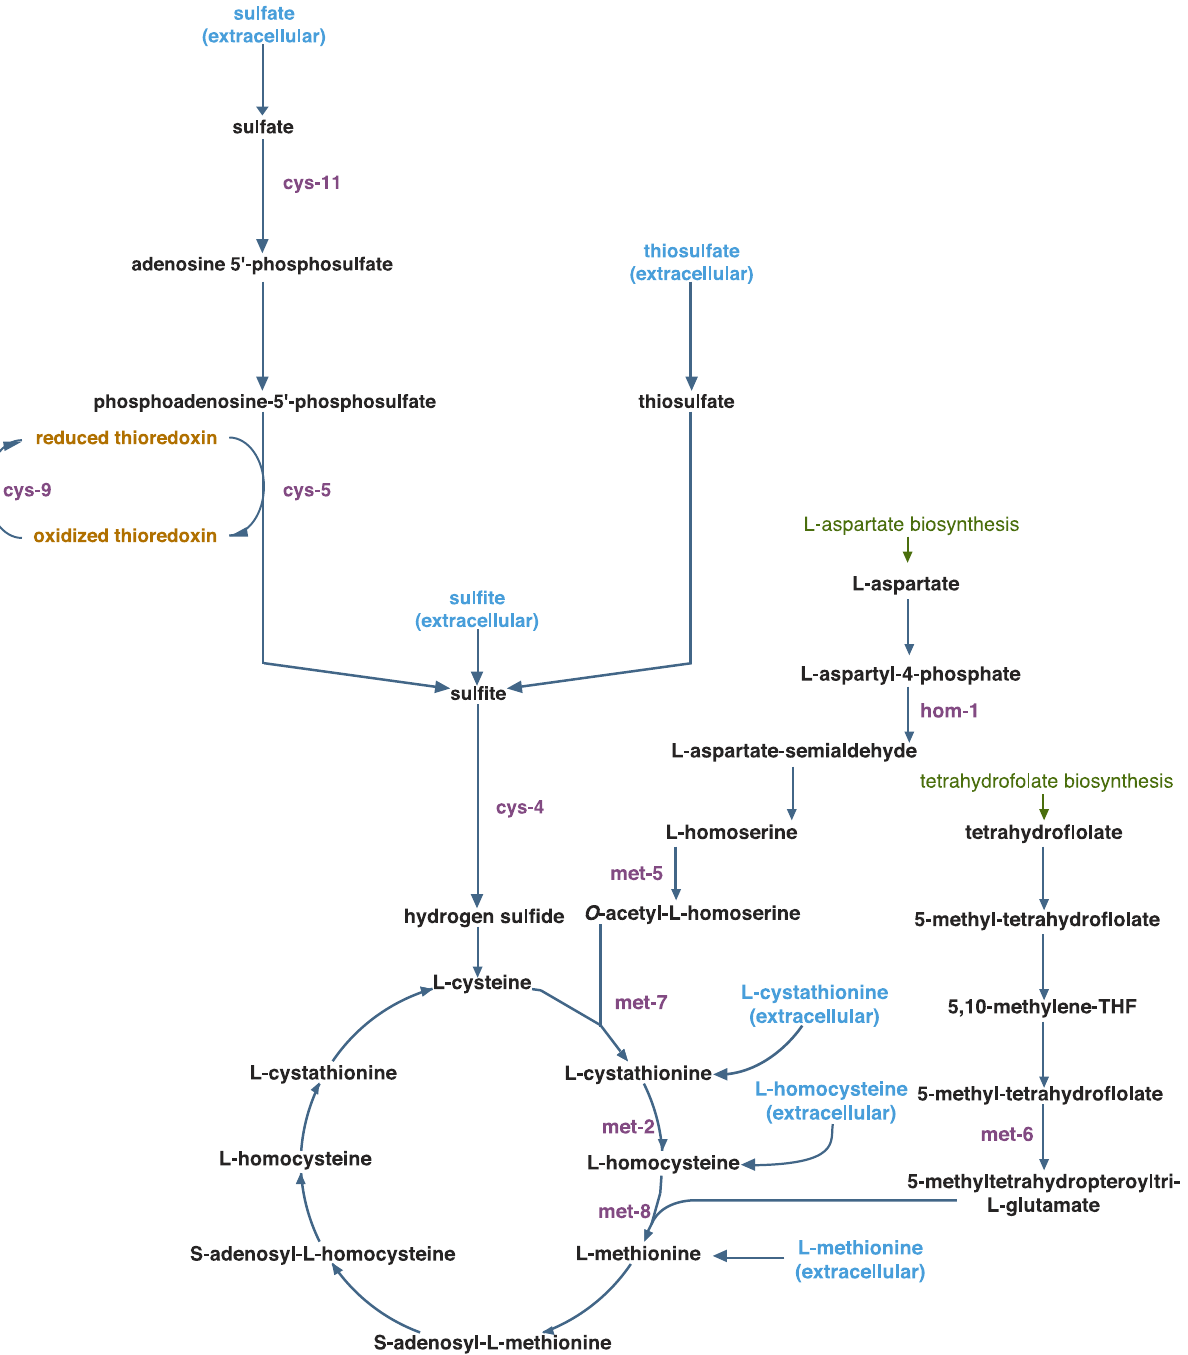
Figure 6. Mechanistic insight into the nutrient rescue of cysteine and methionine metabolism. The model correctly predicts that cys-5 , cys-9 , and cys-11 mutants can be rescued when the downstream nutrients sulfite and thiosulfate are provided in the media. Similarly, the model correctly predicts that met-2 , met-5 , met-6 , met7 and met-8 mutants are rescued by L-methionine; met-2 , met-5 and met-7 mutants are rescued by L-homocysteine; and met-5 and met-7 mutants are rescued by L-cystathione. The model makes the potentially novel predictions that hom-1 and all cys mutants can be rescued by the downstream supplements L-cystathione, L-homocysteine and L-methionine. The model also makes the potentially novel prediction that cys-4 is not rescued by either upstream nutrient supplements sulfite or thiosulfate. Figure S2 illustrates the potential mechanism underlying the predicted synthetic lethality between the suc gene (pyruvate carboxylase) and subunits of mitochondrial complex I (NADH: